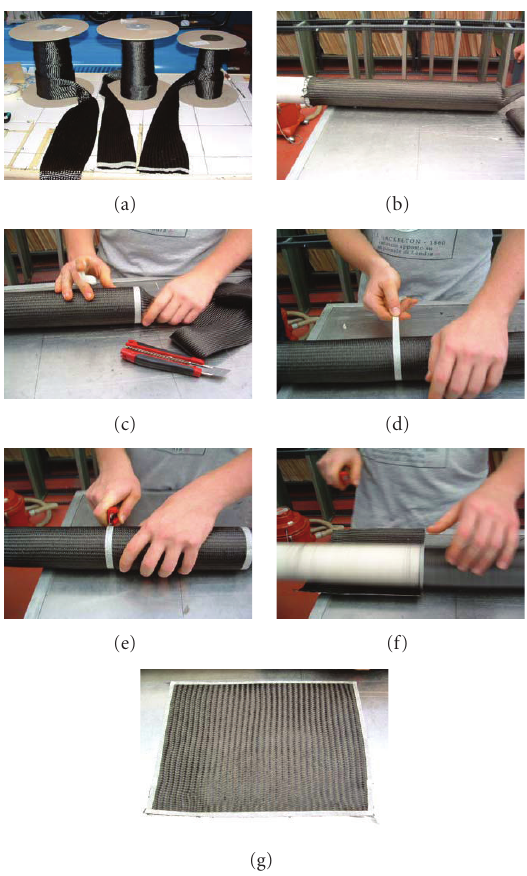
Figure 1: Procedure for cutting a preform to a given braided angle using a PVC mandrel.